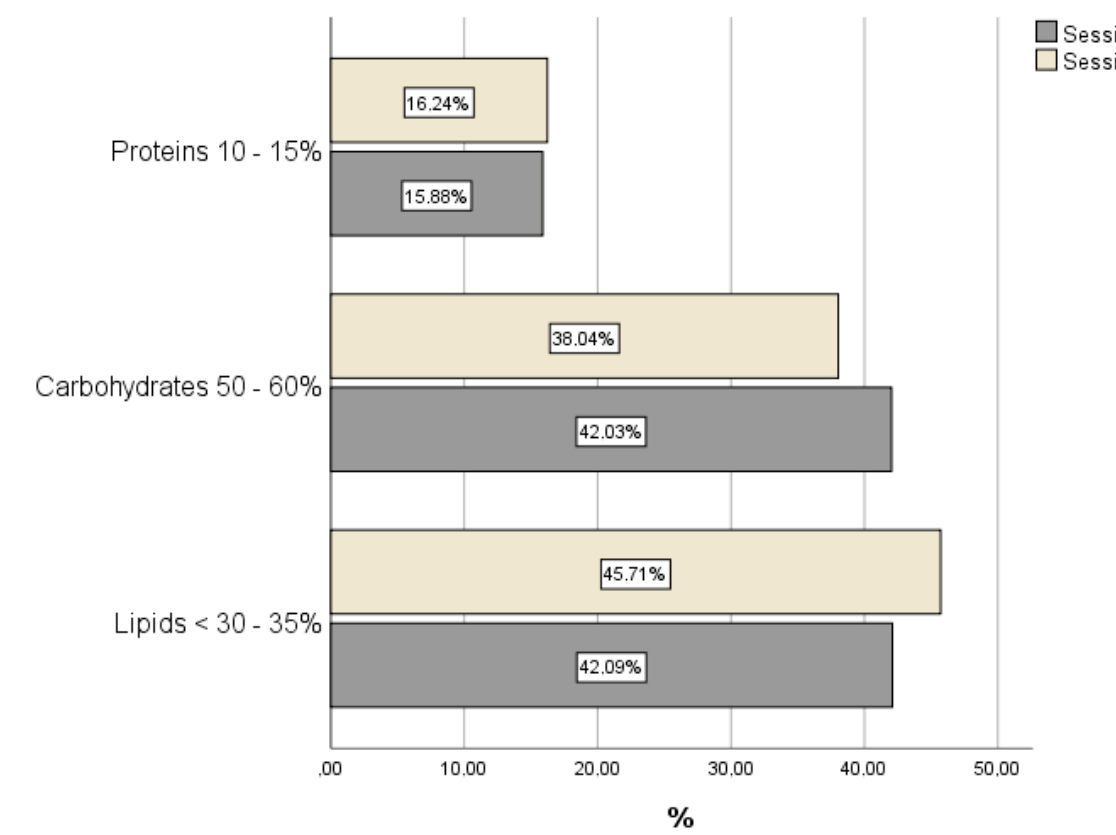
Figure 2. Contribution of macronutrients to total caloric intake during Sessions 2 and 3.